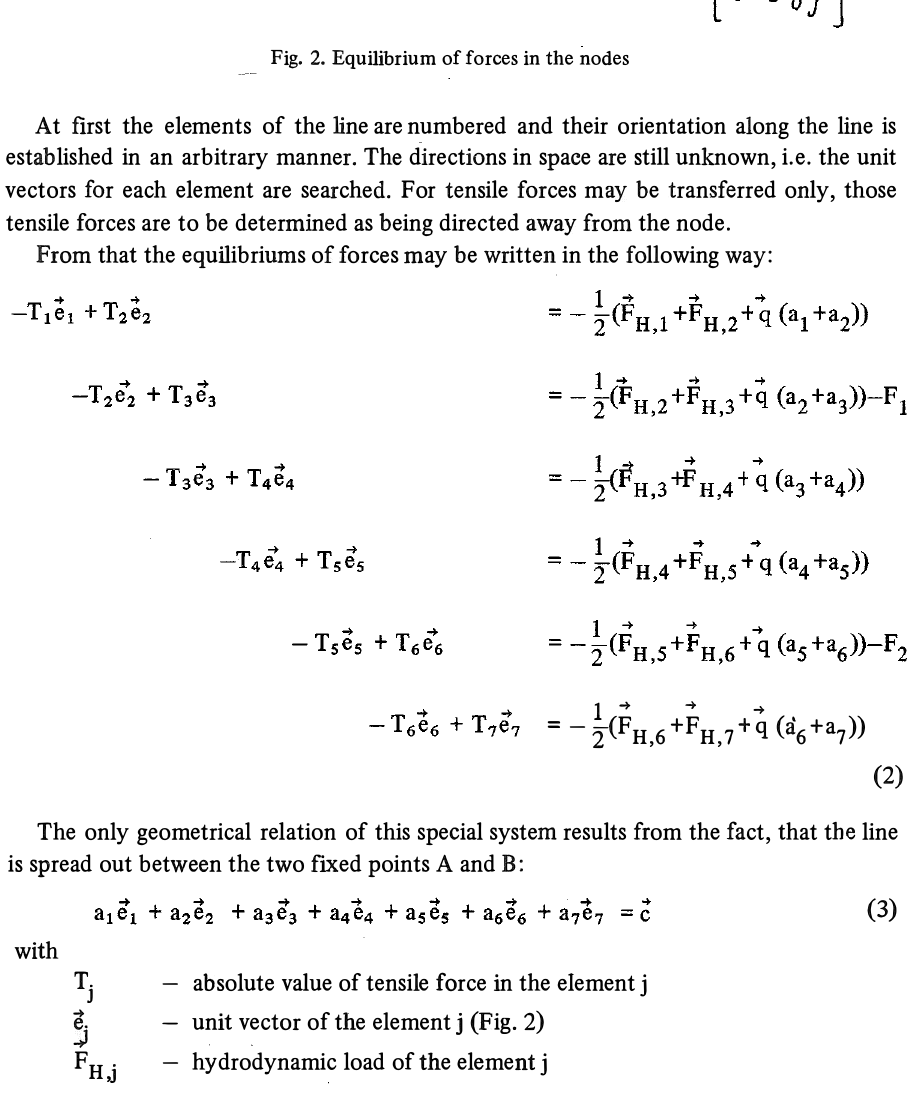
Fig. 2. Equilibrium of forces in the